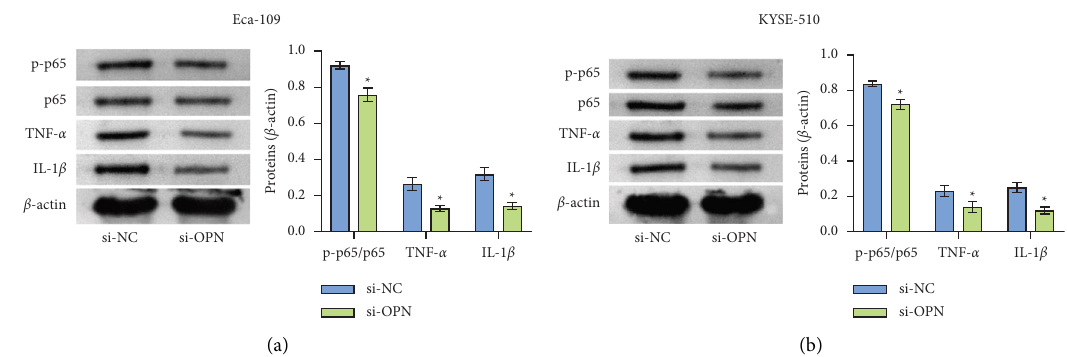
Figure 4: OPN could afect the level of p65 in the Eca-109 and KYSE-510 cells. (a and b) Te level of p65, TNF- α , IL-1 β, and p-p65 in the cells were lower in the si-OPN compared with the si-NC group. ∗ P < 0 . 05 compared with